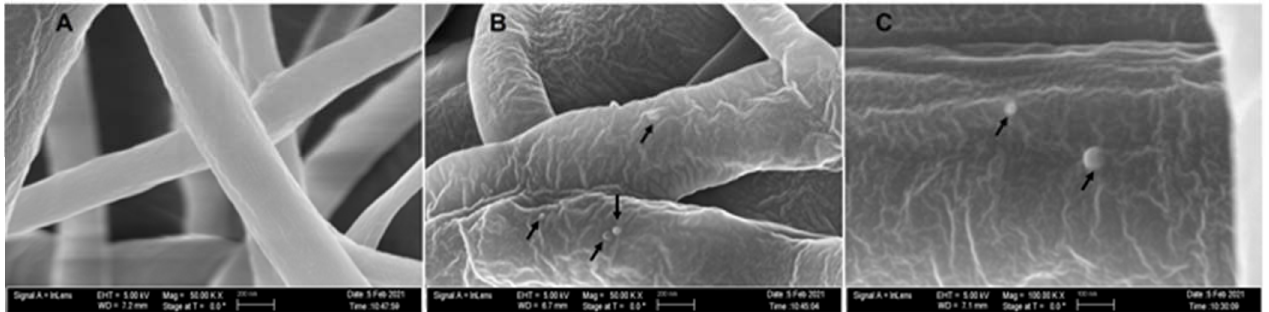
Figure 10. ( A ) represents PCL nanofiber. ( B ) is PCL_Fulbright with black arrows pointing to the phage particles. ( C ) is magnified at 100,000×.